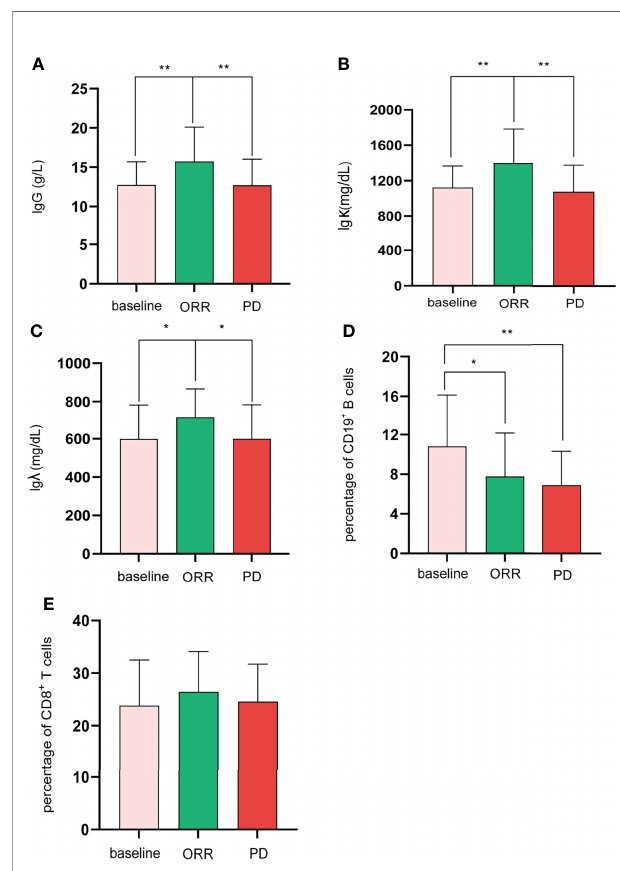
FIGURE 4 | For the difference among baseline, ORR, and PD, Shapiro – Wilk tests were performed to determine the normality of the data distribution. Ig